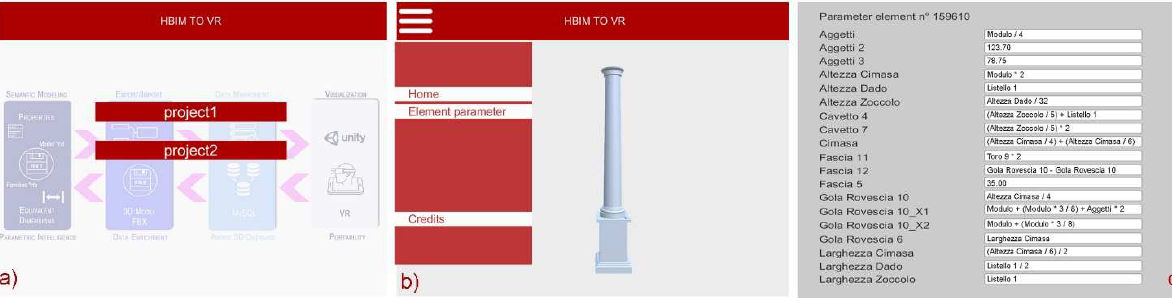
Figure 7. Some screenshots of the application developed: a) list of Revit projects on the server side; b) VR view of project elements and popup menu with programmed features; c) parameters of the selected